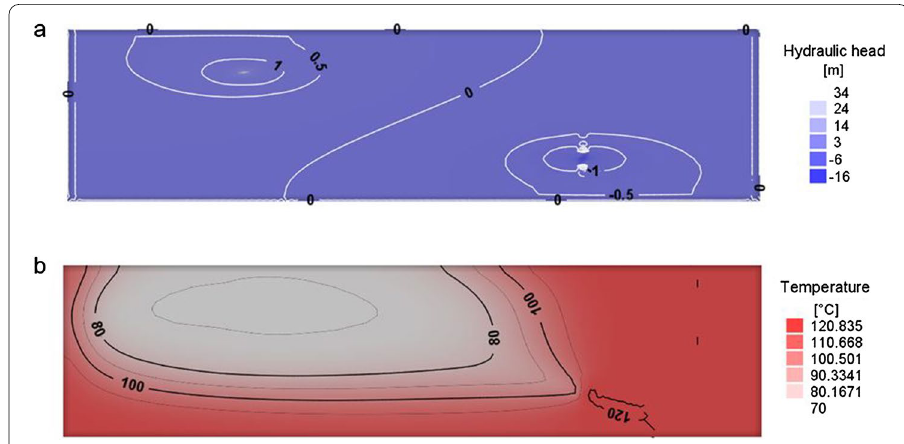
Fig. 4 A cross-section at the wells of a Hydraulic head and b temperature in a geothermal doublet system with a pumping rate of 3000 m 3 d − 1 in the cross-section after 10,950 days (30 years). The fracture density is 1 m − 1 and fracture aperture is 0.3 mm